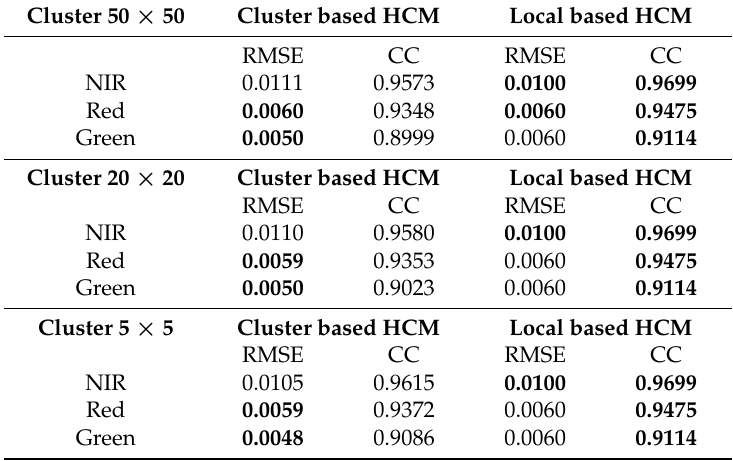
Table 8. Comparison of cluster based HCM with different cluster sizes and local based HCM for homogeneous areas. Bold numbers indicate high performing